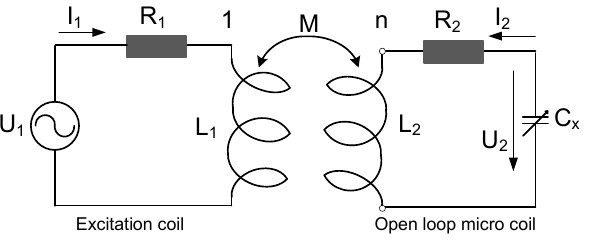
Figure 9. Equivalent electrical circuit model of the inductively cou- pled single micro coil with an electrically small loop